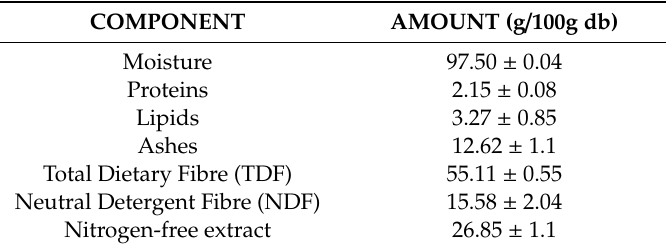
Table 1. Chemical composition of Aloe vera 1